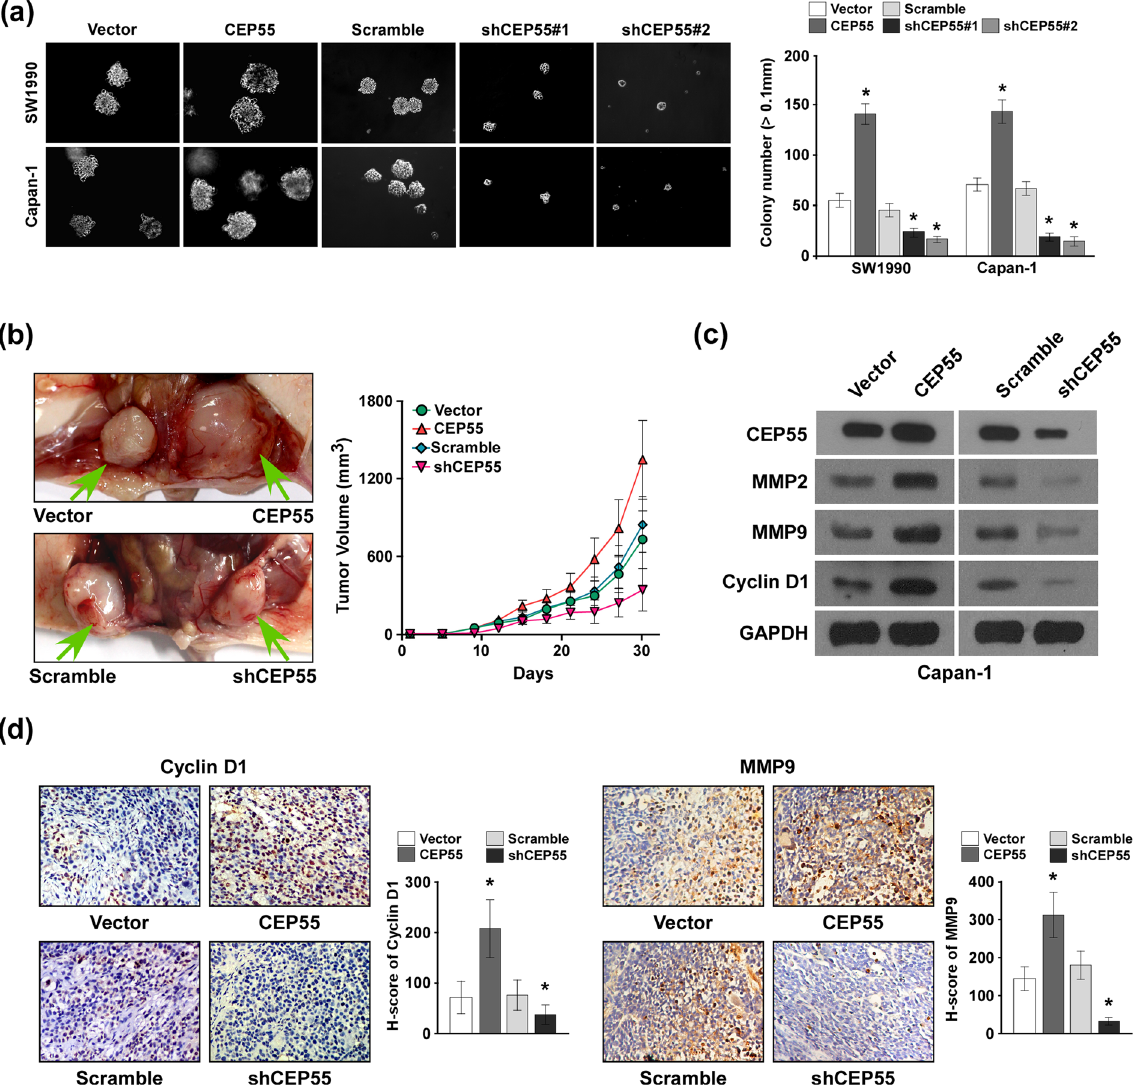
Figure 4. CEP55 overexpression accelerated pancreatic cancer (PANC) cells tumourigenicity in vivo . ( a ) Representative micrographs (left panel) and quantification (right panel) of colonies > 0.1 mm formed in the anchorage-independent growth assay. ( b ) Subcutaneous tumour xenograft model in nude mice; representative images of the tumours formed by CEP55- or shCEP55-transduced Capan-1 cells (left panel, n = 5 per group). Growth curves for tumour formation after implantation of Capan-1 cells transfected with CEP55 or shCEP55 (right panel). ( c ) Western blotting detection of MMP2, MMP9, Cyclin D1 and CEP55 in tumour tissues derived from these mice. Glyceraldehyde-3-phosphate dehydrogenase (GAPDH) was used as a loading control. ( d ) Representative images of an immunohistochemical assay of Cyclin D1 (left panel) and MMP9 (right panel) expression in tumour tissues derived from these mice, magnification × 400. Statistical quantification of the H-score of Cyclin D1 and MMP9 staining in the indicated tissue samples. Bars represent the mean ± SD of three independent experiments. * P <